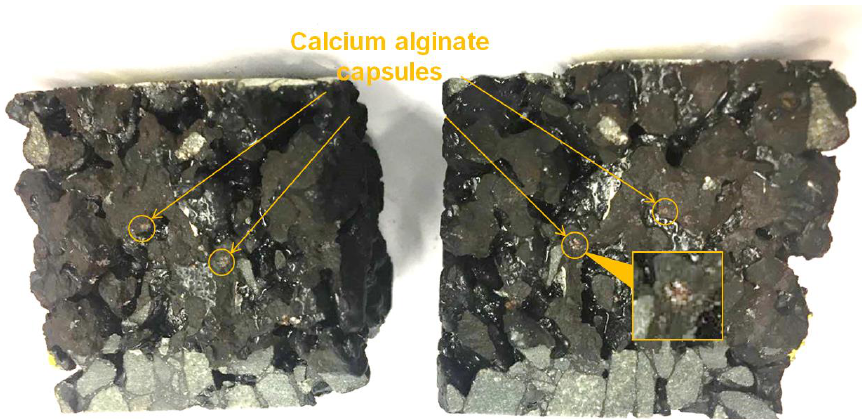
Figure 9. Fracture surface of a SCB specimen with 7% capsules.